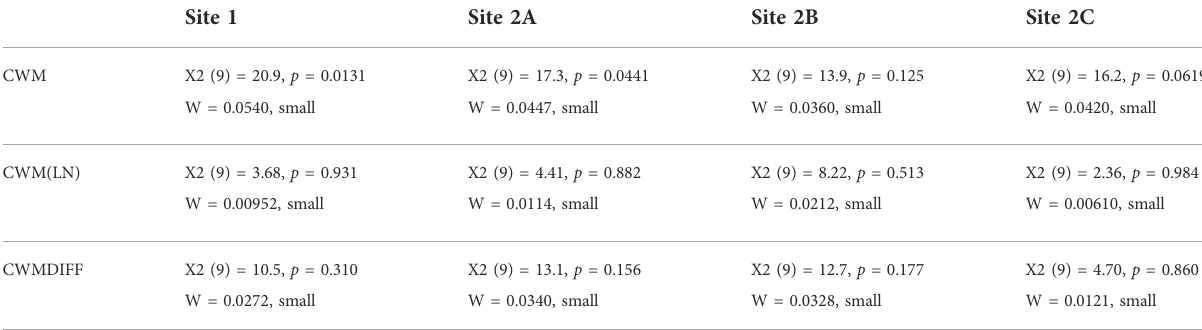
TABLE 3 Summary of the Friedman tests and Kendall ’ s W of CWM, CWM(LN), and CWMDIFF calculated per each